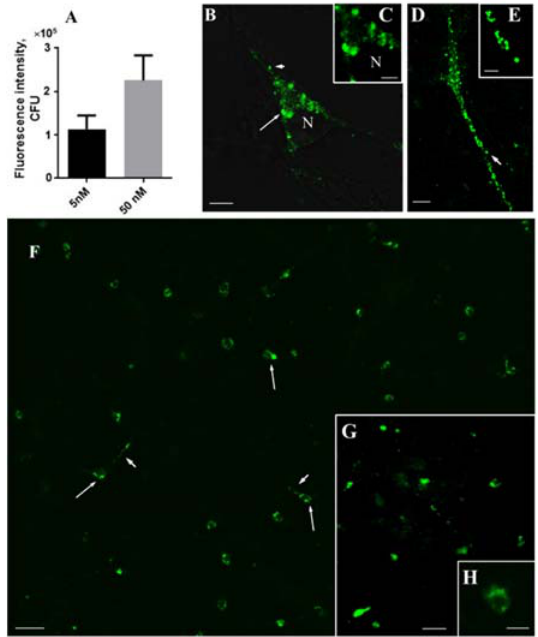
Figure 5. Conventional and confocal fluorescence microscopy of GBR ‐ BP ‐ stained living cells of the primary culture of the mouse embryonic mesencephalon (7th day of cultivation) and living cells of the substantia nigra (vibratome sections) of an adult mouse. ( A ) Fluorescence intensity of cells of the embryonic mesencephalon when incubated with GBR ‐ BP at a concentration of 5 nM or 50 nM. In all experiments ( B – H ), GBR ‐ BP was used at a concentration of 50 nM. ( B , C ) GBR ‐ BP deposition in the neuron cell bodies in rounded vacuoles of various sizes (mesencephalic culture); ( D , E ) GBR-BP deposition in the neuron processes in small rounded vesicular structures (mesencephalic culture); ( F ) general view of a primary mesencephalon culture; ( G , H ) GBR-BP-stained cells in the vibratome sections of adult mouse substantia nigra. Objective magnification = × 64 ( B – E ); objective magnification = × 10 ( F ). arrow, cell body; arrowhead, cell processes. Bars = 5 µ m for ( B , E ); 2.5 µ m for ( C ); 50 µ m for ( F ); 20 µ m for ( G ); 10 µ m for ( H ). CFU, cell fluorescence unit; N,